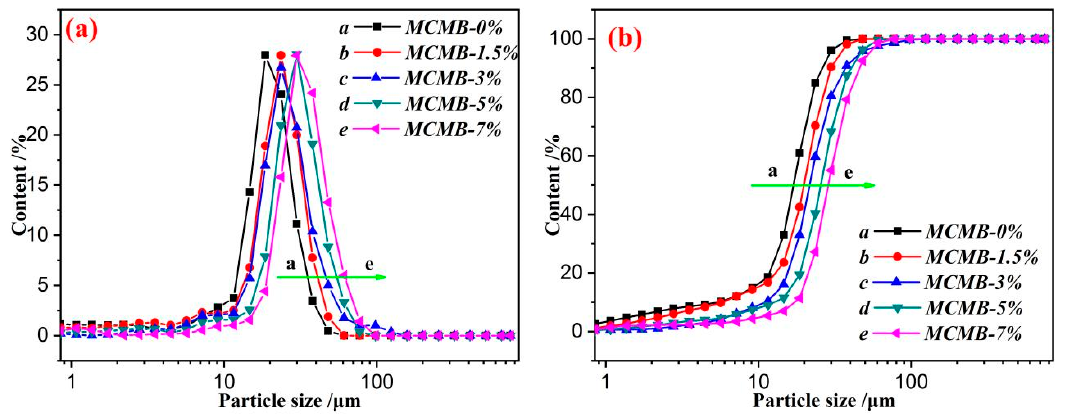
Figure 4. Particle size distribution of MCMBs: ( a ) differential distribution curves and ( b ) cumulative distribution curves. Table 2. The parameters of particle size in